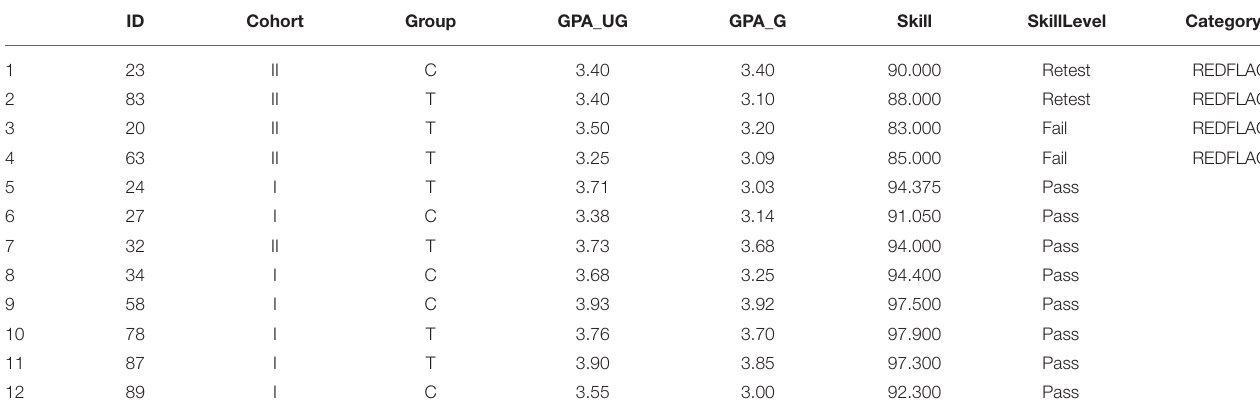
TABLE 2 | Demographic data with adjusted skill scores, factored skill level, and re-sorted based on Red Flag status. ID Cohort Group GPA_UG GPA_G Skill SkillLevel